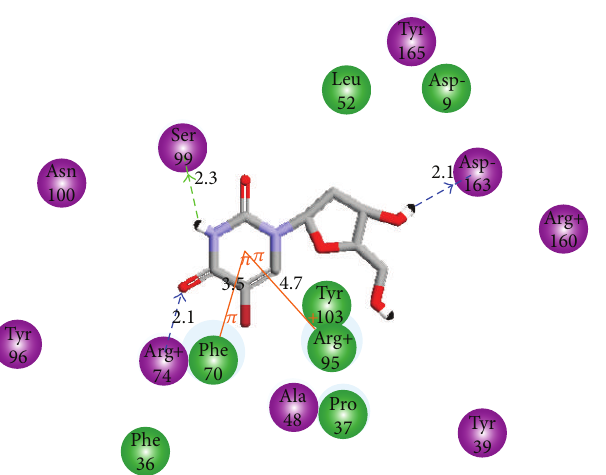
Figure2:InteractionofTMD4withactivesiteresiduesofTMPK mt.